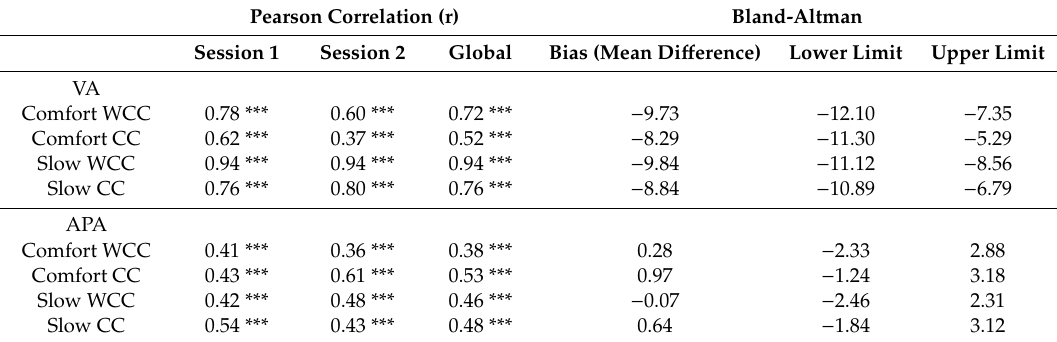
Table 2. Concurrent validity of the acceleration values obtained from the glasses compared to the OptiTrack.